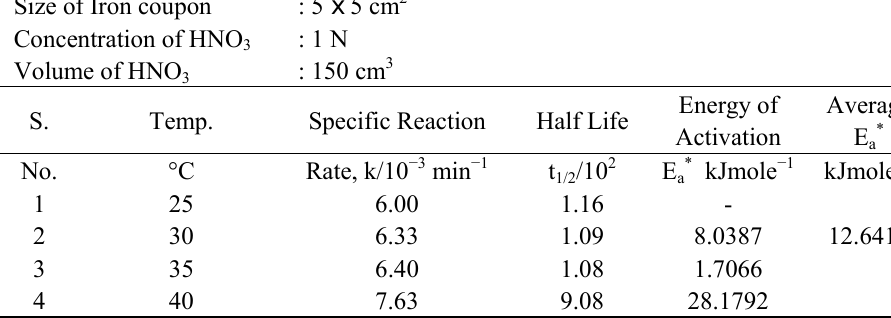
Table 2. Effect of temperature on corrosion rate in nitric acid Size of Iron